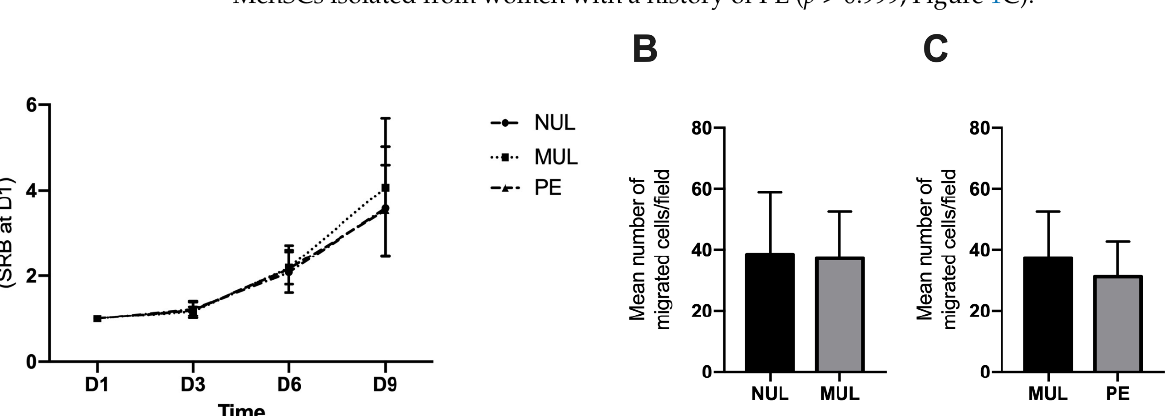
Table 1. Characteristics of controls and preeclampsia donors.